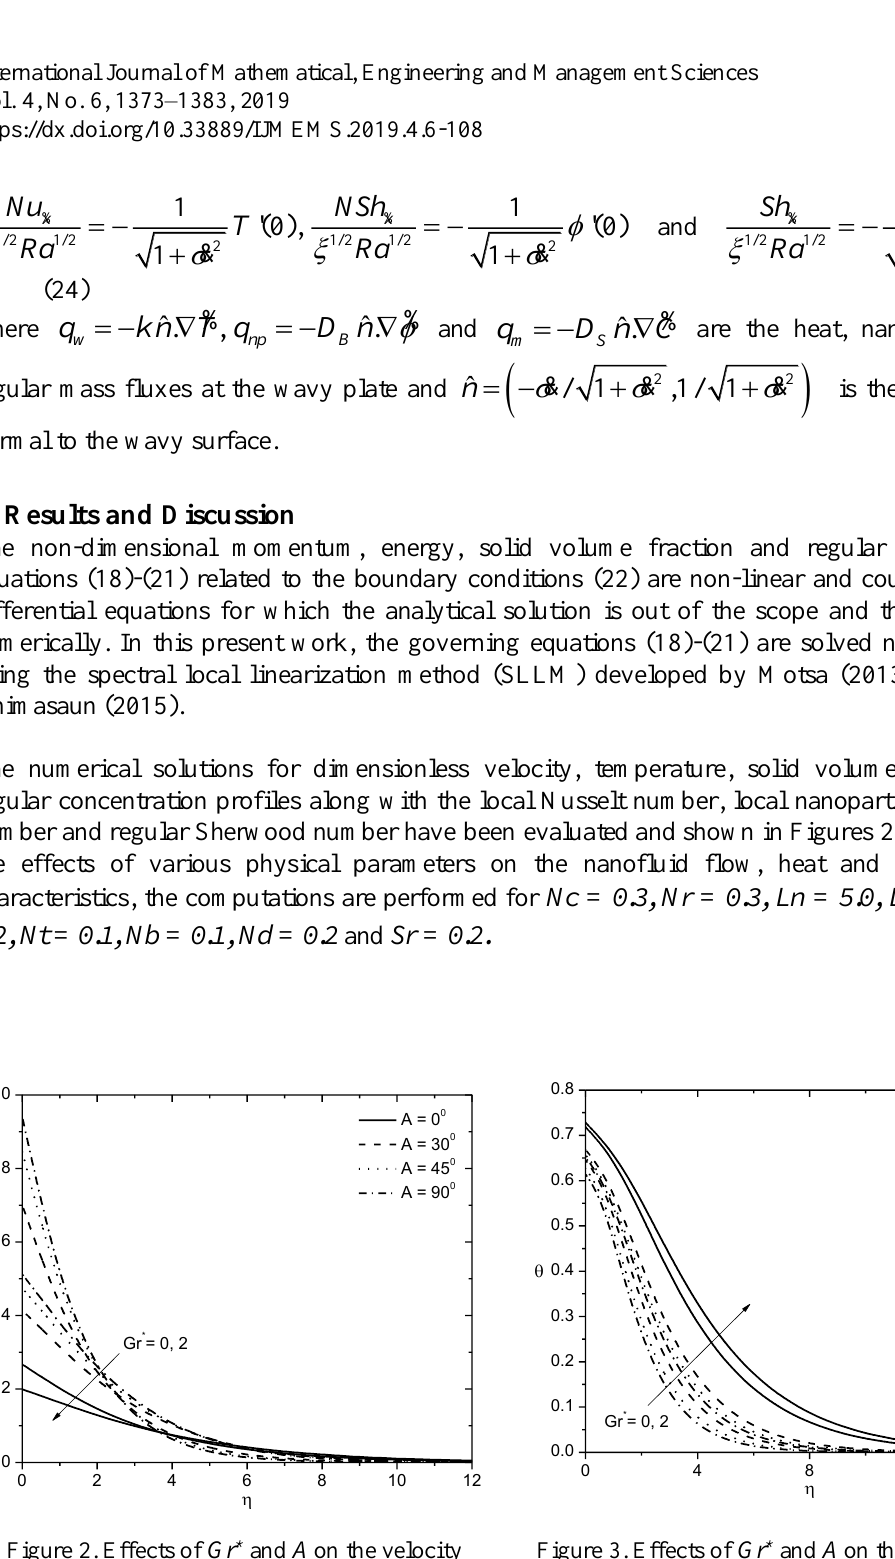
Figure 2. Effects of Gr * and A on the velocity Figure 3. Effects of Gr * and A on the